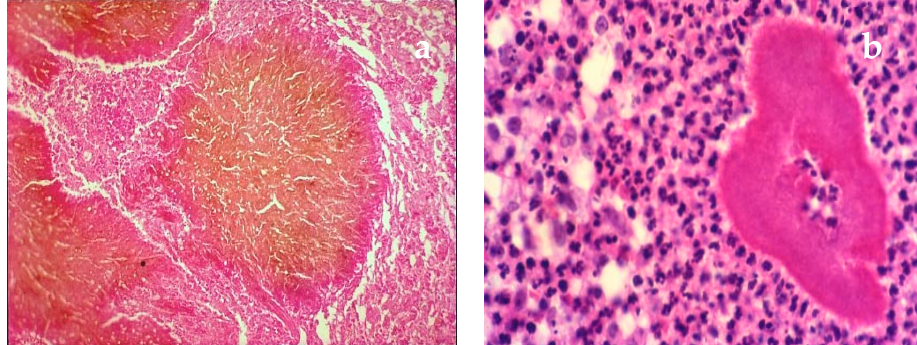
Figure 2. ( a ) Surgical biopsy. Dark grain of eumycetoma M.mycetomatis (Haematoxylin eosin HE) × 40; ( b ) Deep biopsy. Grain of Nocardia brasiliensis (HE) × 40.